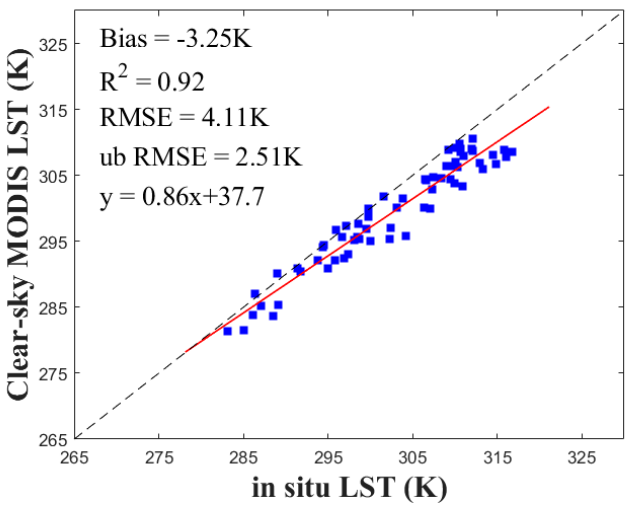
Figure 9. Scatter plot of the clear-sky MODIS LST versus in situ measurements.